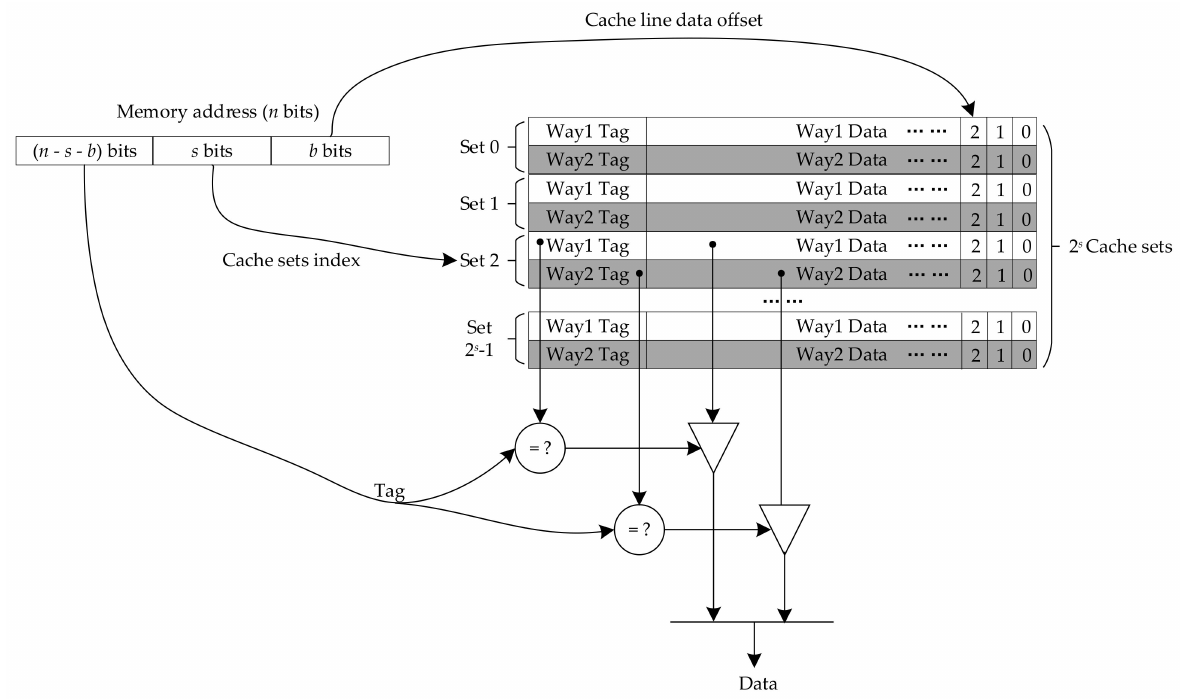
Figure 1. Example of 2-way set-associate